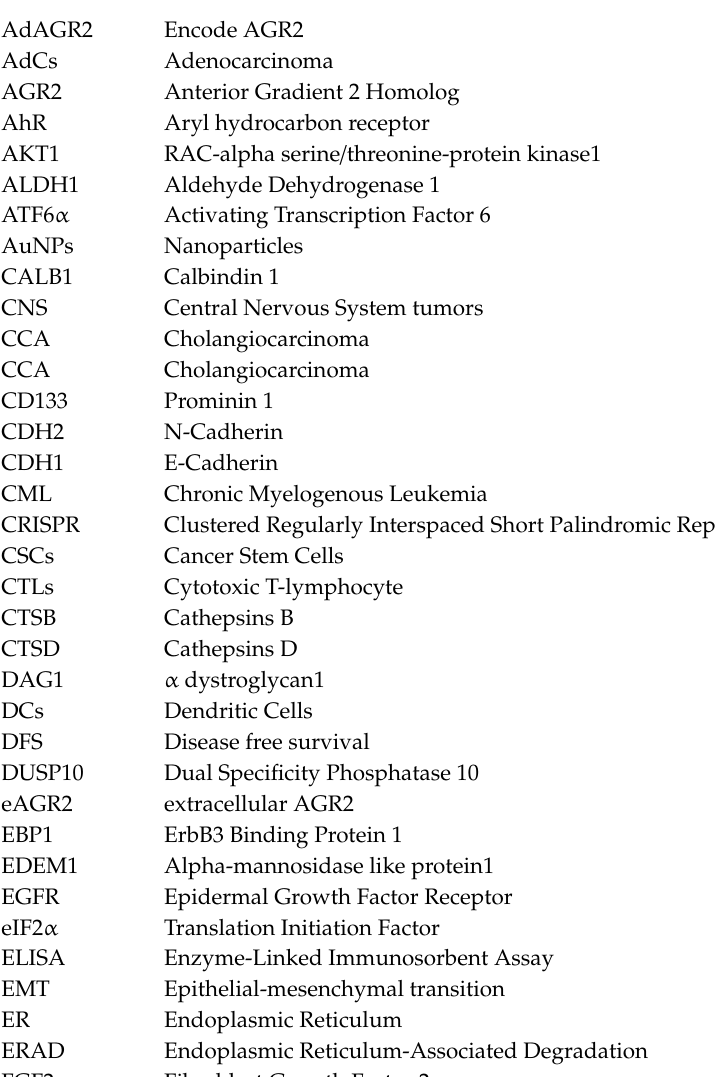
Table S1: All 245 di ff erentially expressed genes detected in meningiomas with high AGR2